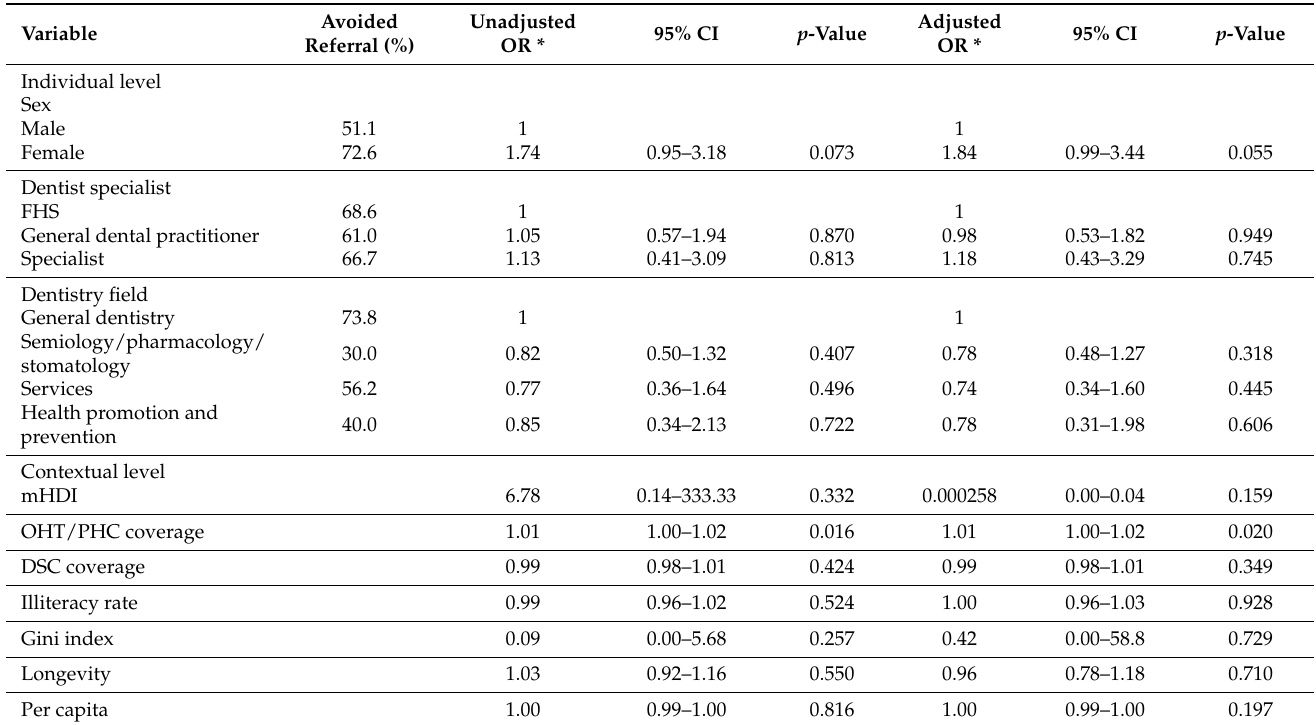
Table 5. Multilevel models (unadjusted and adjusted) for variables of individual (n = 1,319) and contextual levels associated with avoiding patient referral to other care